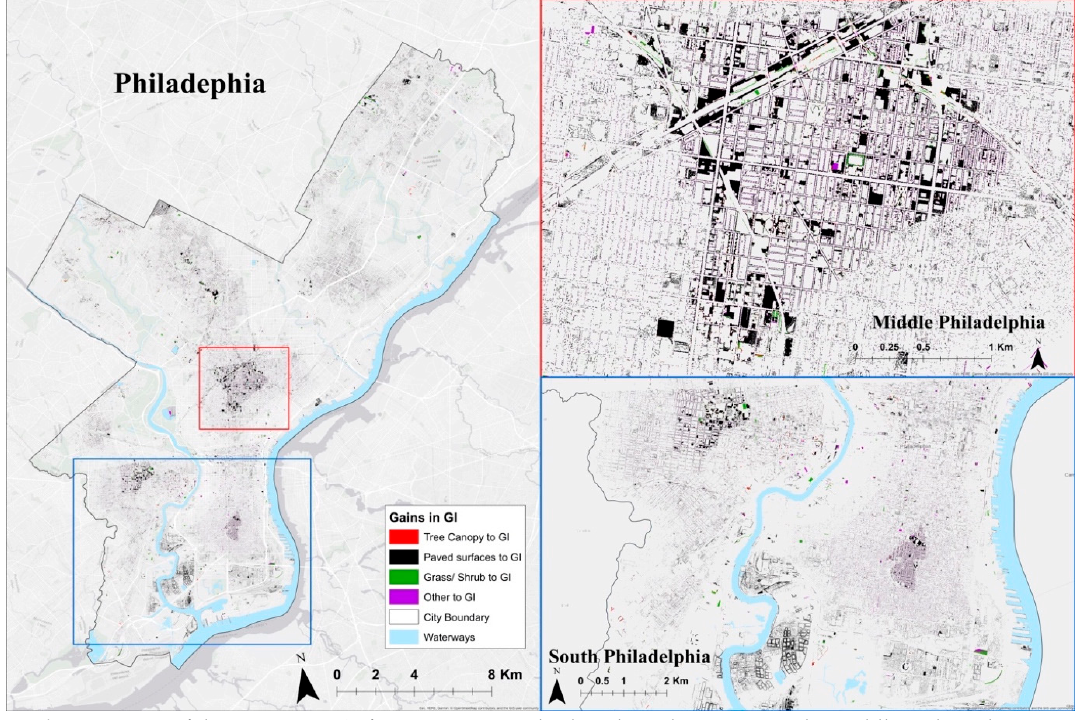
Figure 6. Map of the increase in GI from 2008 to 2036 broken down by category. The middle and southern portions of Philadelphia are highlighted (“Other to GI” includes buildings and roads/railroads transitioning to GI).